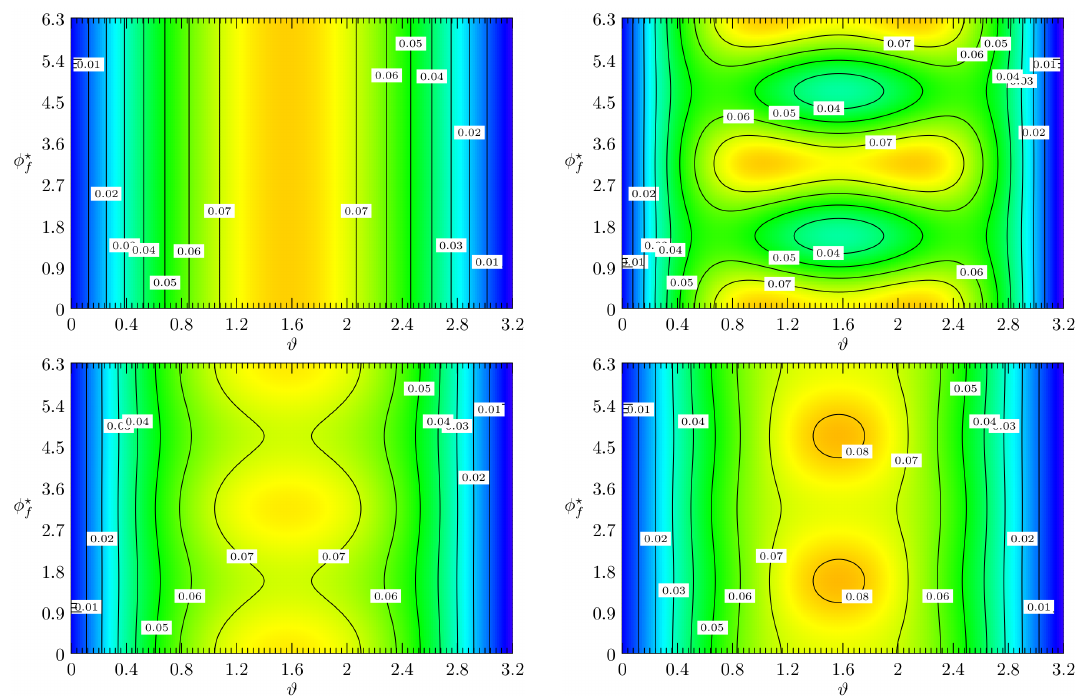
Figure 12 . Contour plots in the plane of the lepton azimuthal angle φ ? angle ϑ for the gQGC operators O and O (lower right). These results are for a gluon-gluon collision energy gT, (3 , 7)